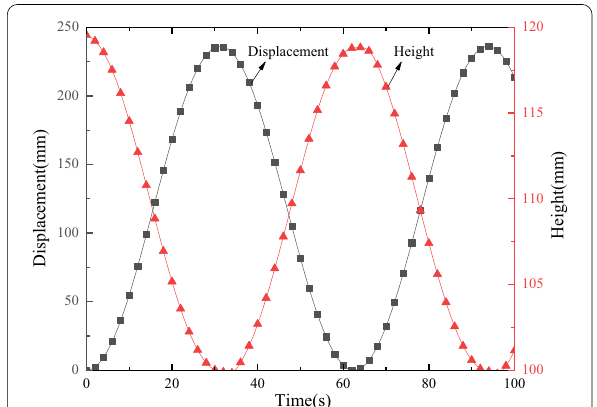
Figure 10 The height changes with